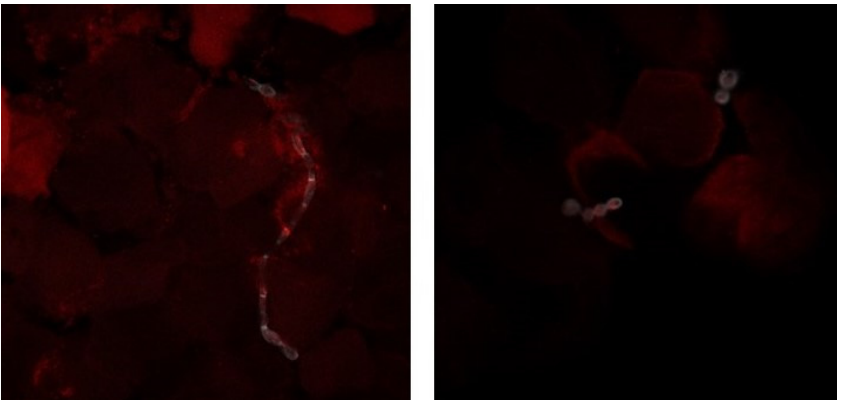
Figure 2. Confocal fluorescence microscopy of nail samples. The nails were treated with KOH and stained with Evans-blue and calcofluor. The images are illustrative of the samples studied by this technique. On the left side picture, a dermatophyte infecting the nail can be seen and on the right yeast forms in the nail material can be seen. (20× and 63×/1.40 immersion objectives)